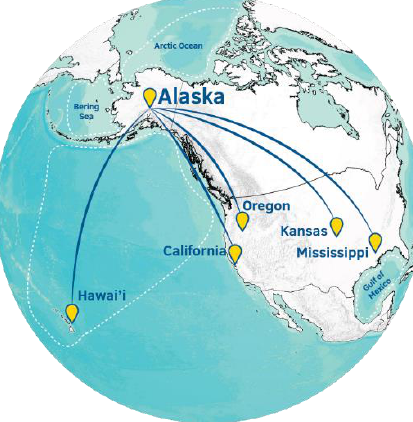
Figure 3. University of Alaska Fairbanks (UAF)/ Alaska Center for Unmanned Aircraft Systems Integration’s (ACUASI’s) Pan Pacific UAS Test Range Complex (PPUTRC) partner locations [18] (p. 1).